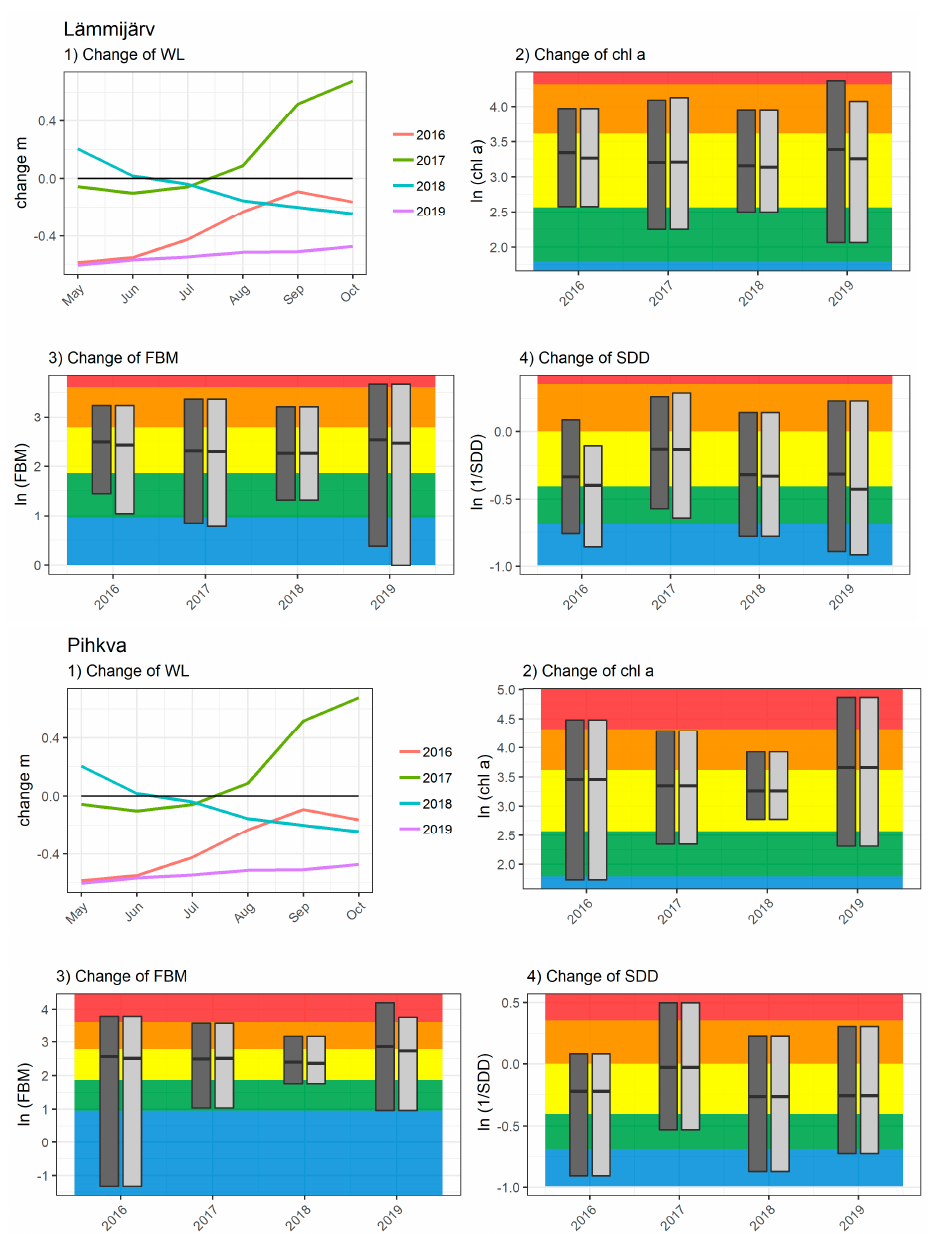
Figure A2. Water level change from long-term monthly mean WL during the study period in Peipsi s.s. , Lämmijärv, and Pihkva ( 1 ). Value 0 indicates long-term monthly mean WL. Mean, maximum, and minimum values of water quality parameters are represented on the graphs ( 2 – 4 ), where dark gray indicates values before and light gray indicates values after applying WL correction. Different colors represent ecological classes according to EU WFD.